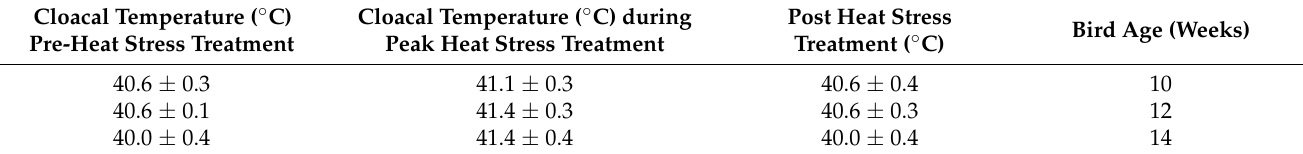
Table 3. Cloacal temperatures (average ± SD) of turkeys at each age period (10 week, 12 week and 14 week) 10 min before (pre heat stress treatment), after birds had experienced peak temperatures for 2 h (during peak heating), and 2 h after the imposed heat stress (post heat stress treatment).